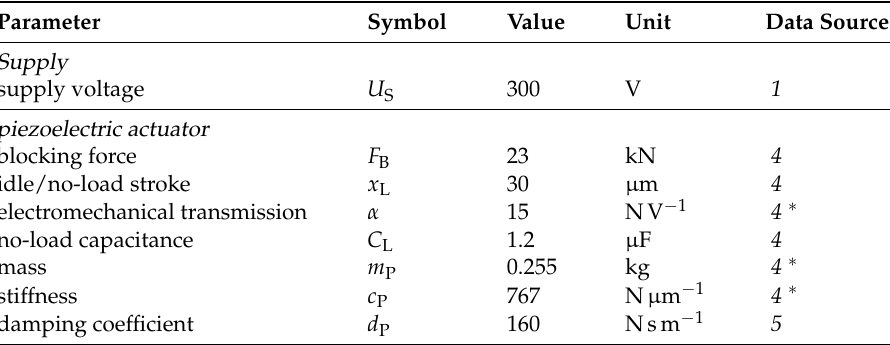
Table A2. Numerical values for the test setup and